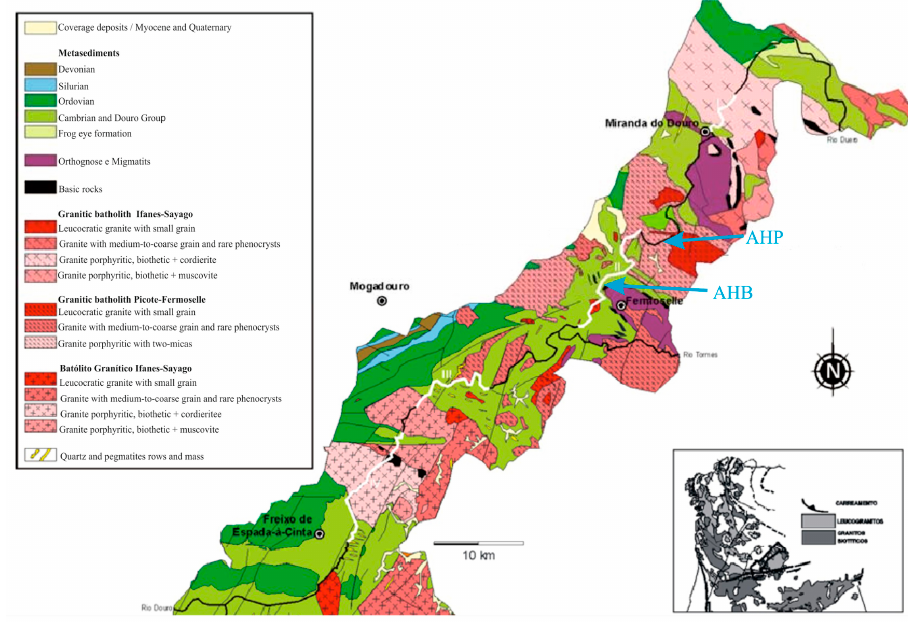
Figure 4. Infographics of geological settings at Picote II (AHP) and Bemposta II (AHB) (adapted from [34]).